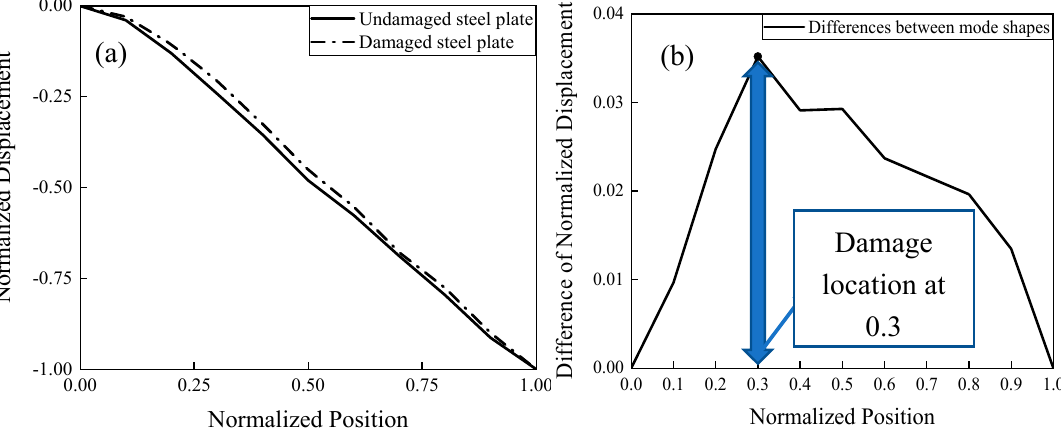
Figure 16. Mode shape analysis. ( a ) Mode shapes of the undamaged and the damaged steel beam. ( b ) Differences in the normalized displacement between the undamaged mode shape and damaged mode shape.